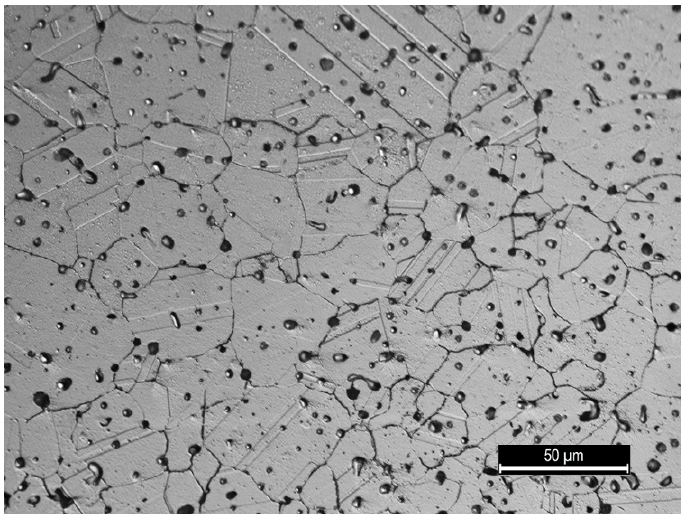
Figure 7. Microstructure of a SAE 316L stainless steel final part produced by powder hot embossing: austenite grains with visible porous.